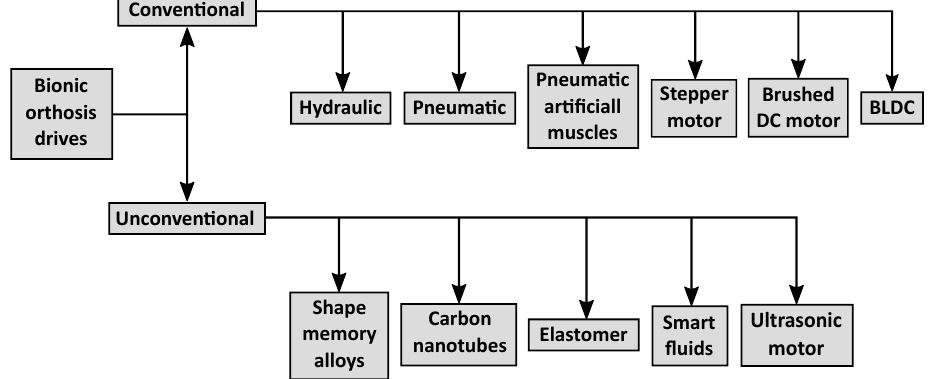
Figure 3. Types of bionic orthosis drives.